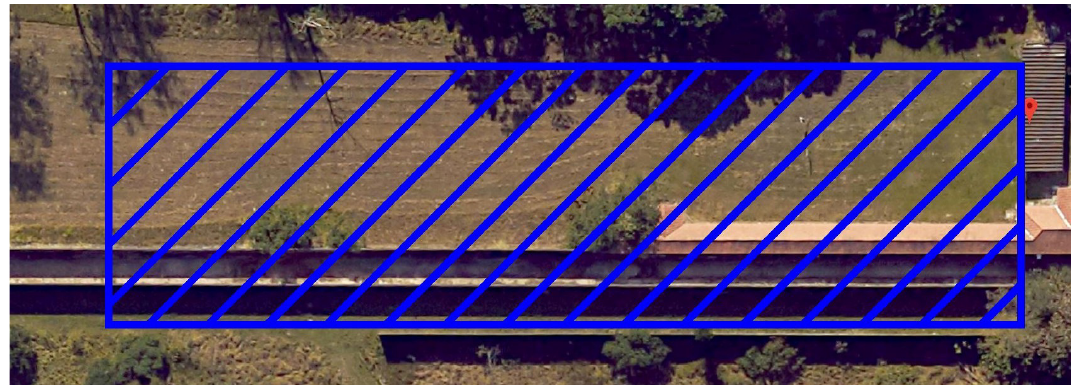
Figure 6. Shooting site: In red (marker) is shooter location, and in blue is the allowed flight zone of the drone. Adapted from Google Maps [65].